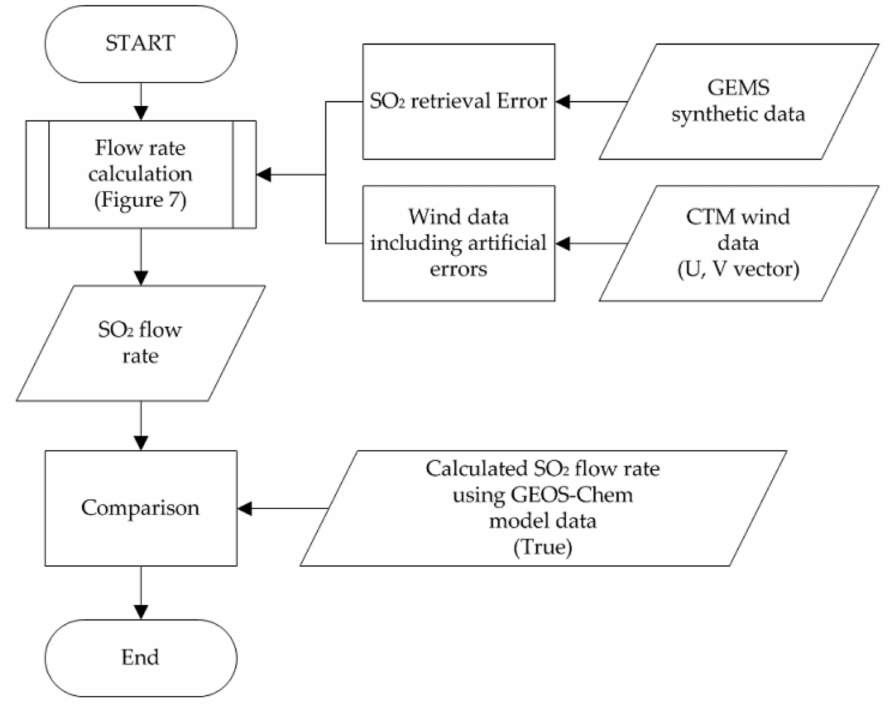
Figure 8. Flowchart used to estimate the uncertainty of the LRT-SO 2 flow rate retrieval.